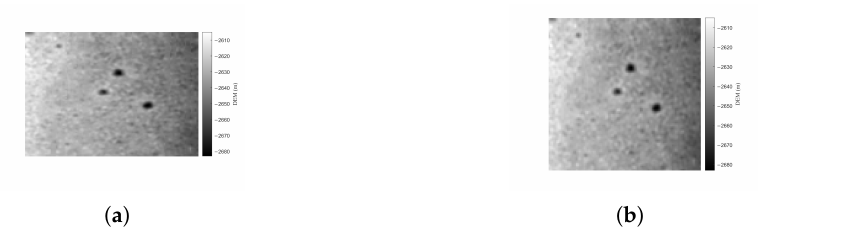
Figure A2. Chang’e-3 landing region. The conversion of the selected area’s spatial resolution to the target’s spatial resolution: ( a ) the original image used SLDEM data and ( b ) the new image with adjusted spatial resolution.